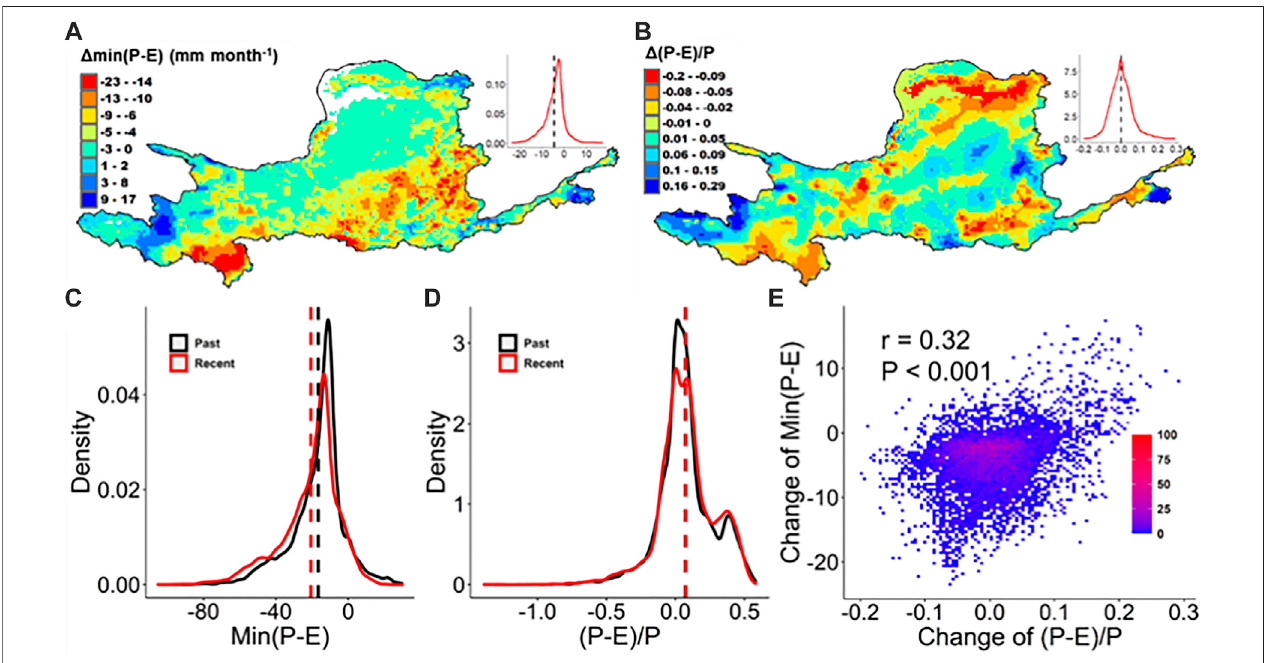
FIGURE 1 | Change patterns in dry-season water availability. (A) Spatial pattern of changes in min (P – E) between past (1982 – 1999) and recent (2000 – 2016) periods. (B) Spatial pattern of changes in (P – E)/P between past and recent periods. (C,D) Density of min (P – E) and (P – E)/P in both past and recent periods. (E) Correlation (Pearson ’ s r) between Δ min (P – E) and Δ (P – E)/P. P and E mean the precipitation and evapotranspiration, respectively.